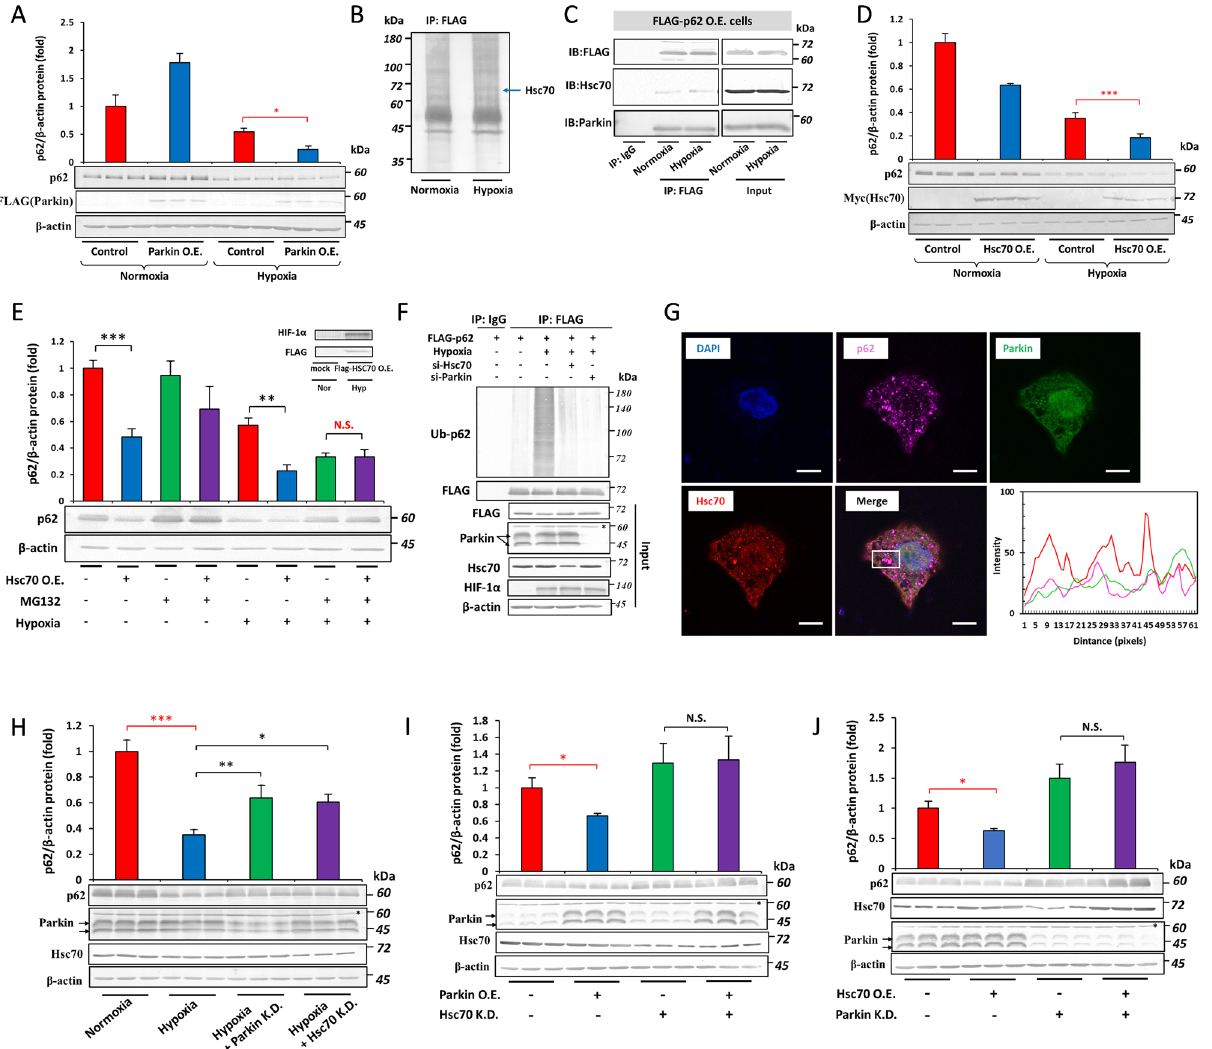
Figure 4. The Parkin-Hsc70 complex regulates the stability of the p62 protein under hypoxia. ( A ) Parkin in 3 × FLAG-pcDNA4 was transfected into Hep3B cells, cells were then incubated under normoxia or hypoxia (O 2 = 1%) for 12 h, and p62 protein levels were examined by immunoblotting. ( B ) FLAG-Parkin was overexpressed in Hep3B cells, cultured under normoxia or hypoxia for 12 h, and immunoprecipitated with the anti-FLAG antibody. The band indicated by the arrow was analyzed by LC–MS. ( C ) Hep3B cells were transfected with the FLAG-p62, cell lysates were immunoprecipitated with an anti-FLAG antibody, and immunoprecipitated proteins were subjected to an immunoblotting analysis with anti-FLAG, anti-Hsc70, and anti-Parkin antibodies. ( D ) Hep3B cells were transfected with FLAG-Hsc70, incubated under normoxia or hypoxia for 12 h, and p62 protein levels were examined by immunoblotting. ( E ) FLAG-Hsc70 was transfected into Hep3B cells, incubated under normoxia or hypoxia for 12 h, treated with 5 µM MG132, and p62 protein levels were examined by immunoblotting. ( F ) FLAG-p62 was transfected with siRNA-Control, siRNA-Parkin, or siRNA-Hsc70, grown under normoxia or hypoxia for 12 h in the presence of 5 µM MG132, and cell lysates were immunoprecipitated using an anti-FLAG antibody, and subjected to immunoblotting. ( G ) Hep3B cells were transfected with pcDNA-Parkin-Venus and the cellular co-localization of p62 (magenta), Parkin (green), Hsc70 (red), and DAPI (blue) was examined by immunofluorescence, scale bar: 10 μm. The histogram shows the fluorescence intensity of channels along the white box in the merged image. (H) Hep3B cells were transfected with siRNA-Control, siRNA-Parkin (Parkin K.D.), or siRNA-Hsc70 (Hsc70 K.D.), incubated under normoxia or hypoxia for 12 h, and p62 protein levels were examined by immunoblotting. ( I ) pcDNA-Parkin was co-transfected with siRNA-Control or siRNA-Hsc70, incubated under hypoxia for 12 h, and subjected to immunoblotting to assess p62 protein levels. ( J ) pcDNA-Hsc70 was co-transfected with siRNA-Control or siRNA-Parkin, incubated under hypoxia for 12 h, and subjected to immunoblotting. Data are presented as the mean ± S.D. of triplicate experiments. N.S. not significant, * p < 0.05, *** p < 0.001 versus the indicated group, calculated with a one-way ANOVA with Tukey’s post-hoc